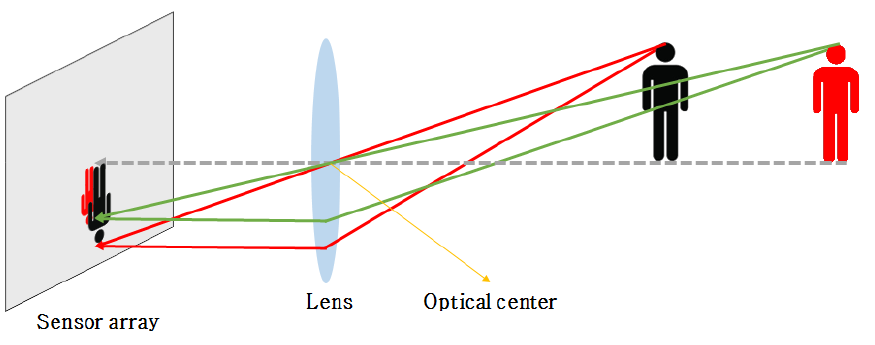
Figure 1. Projective model of the camera.